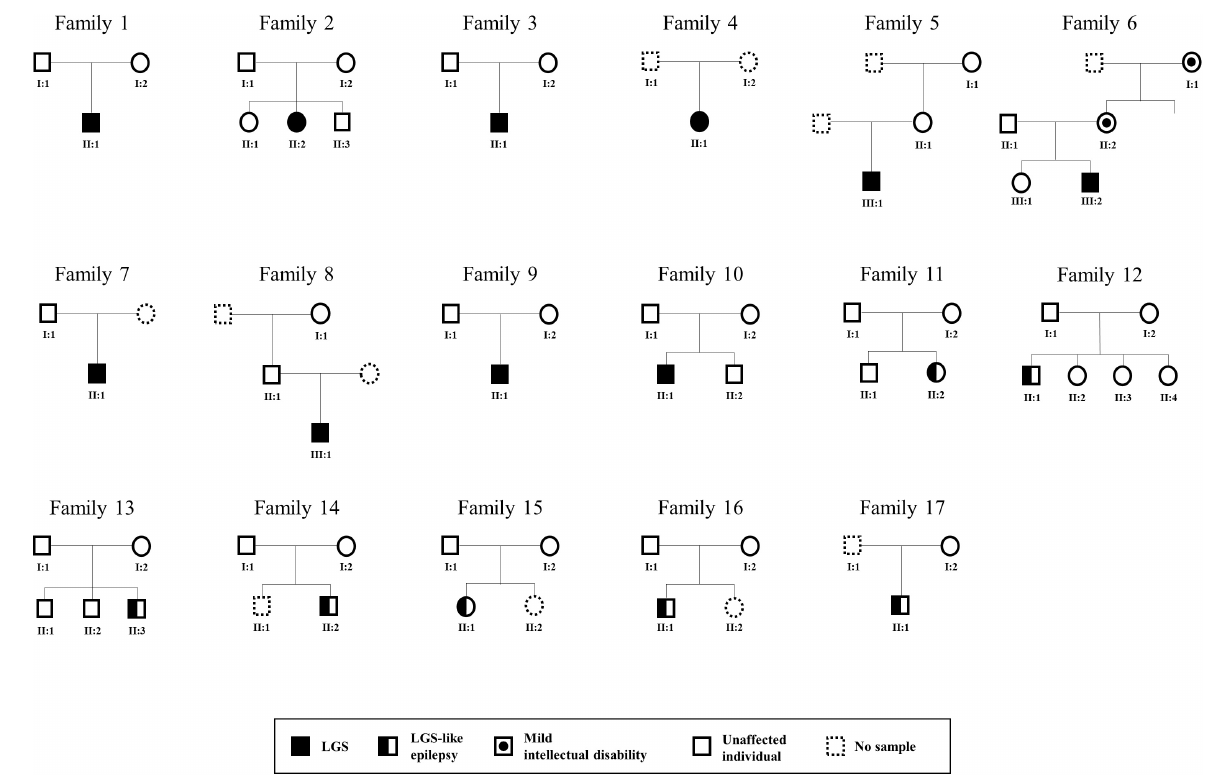
FIGURE 2 | Pedigree of LGS or LGS-like epilepsy families. Males and females are represented as squares and circles, respectively. Patients with LGS are indicated as completely filled symbols, and those with LGS-like epilepsy are indicated as half-filled symbols. The circle with dots indicates females with mild intellectual